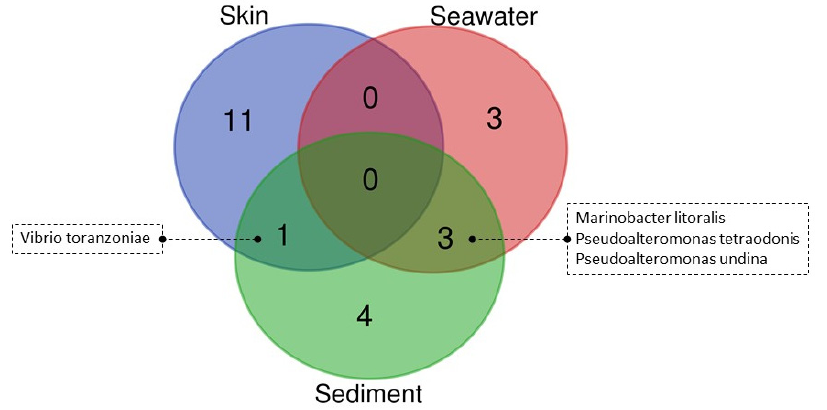
Figure 4. Venn diagram of the bacterial species that were identified in culturable microbiota of fish skin, seawater, and sediment associated with marine fish farm